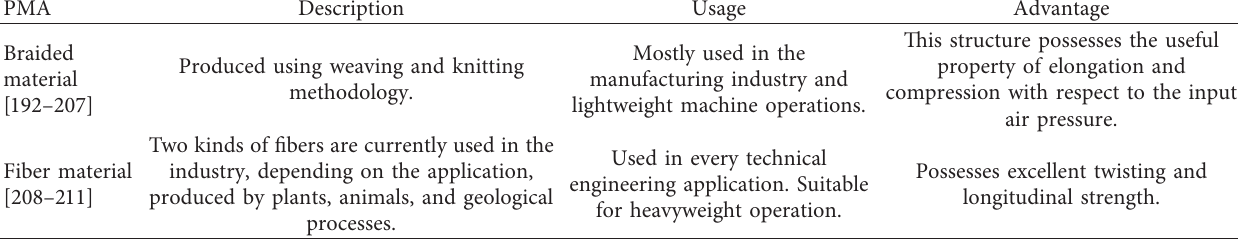
Table 6: Braided and fiber material for the pneumatic actuator.